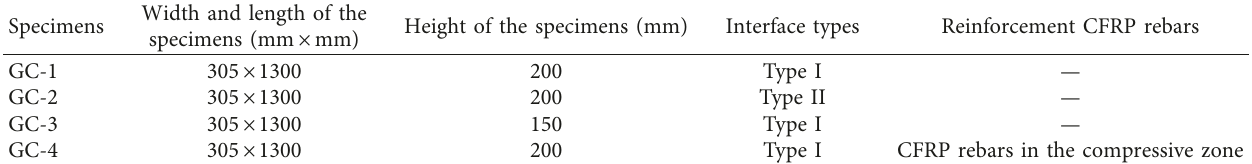
Table 1: Details of all